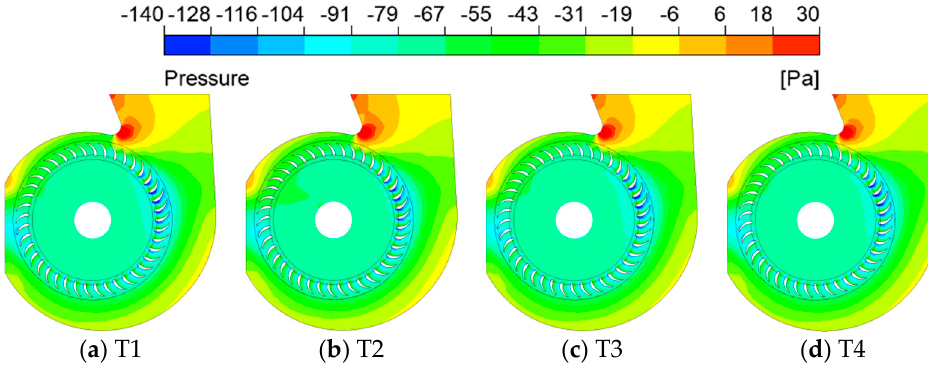
Figure 9. Distribution of static pressure on Z = 4 mm cross-section for the r = 9 mm model.